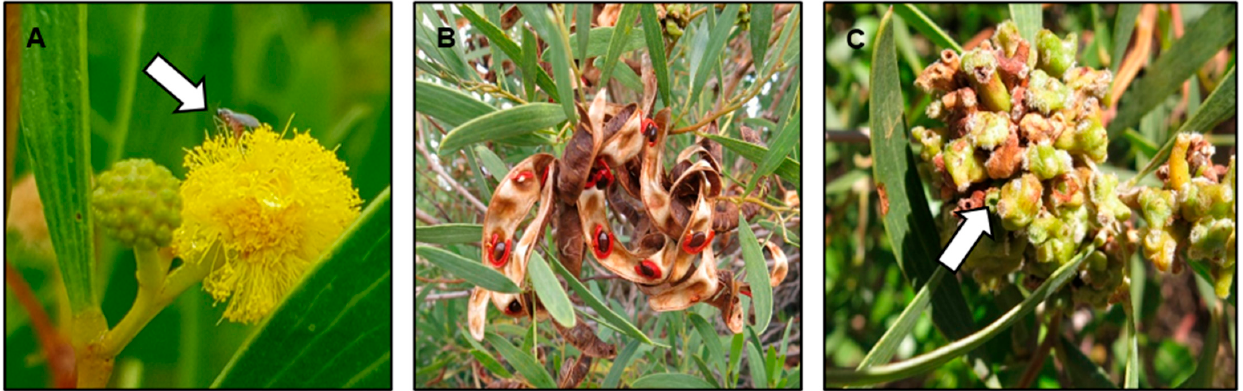
Figure 1. ( A ) Adult Dasineura dielsi (lateral view) on an Acacia cyclops inflorescence. ( B ) Intact A. cyclops seed pods, which encase black oval-shaped seeds with distinctive red funicles. ( C ) Gall cluster resulting from D. dielsi oviposition, whereby the ovary wall evaginates from the resultant larvae feeding and this prevents seed production of the inflorescence [31]. Adult midges then emerge from the ostioles (i.e., emergence holes) observed along the gall cluster. ©Kayla Liebenberg.